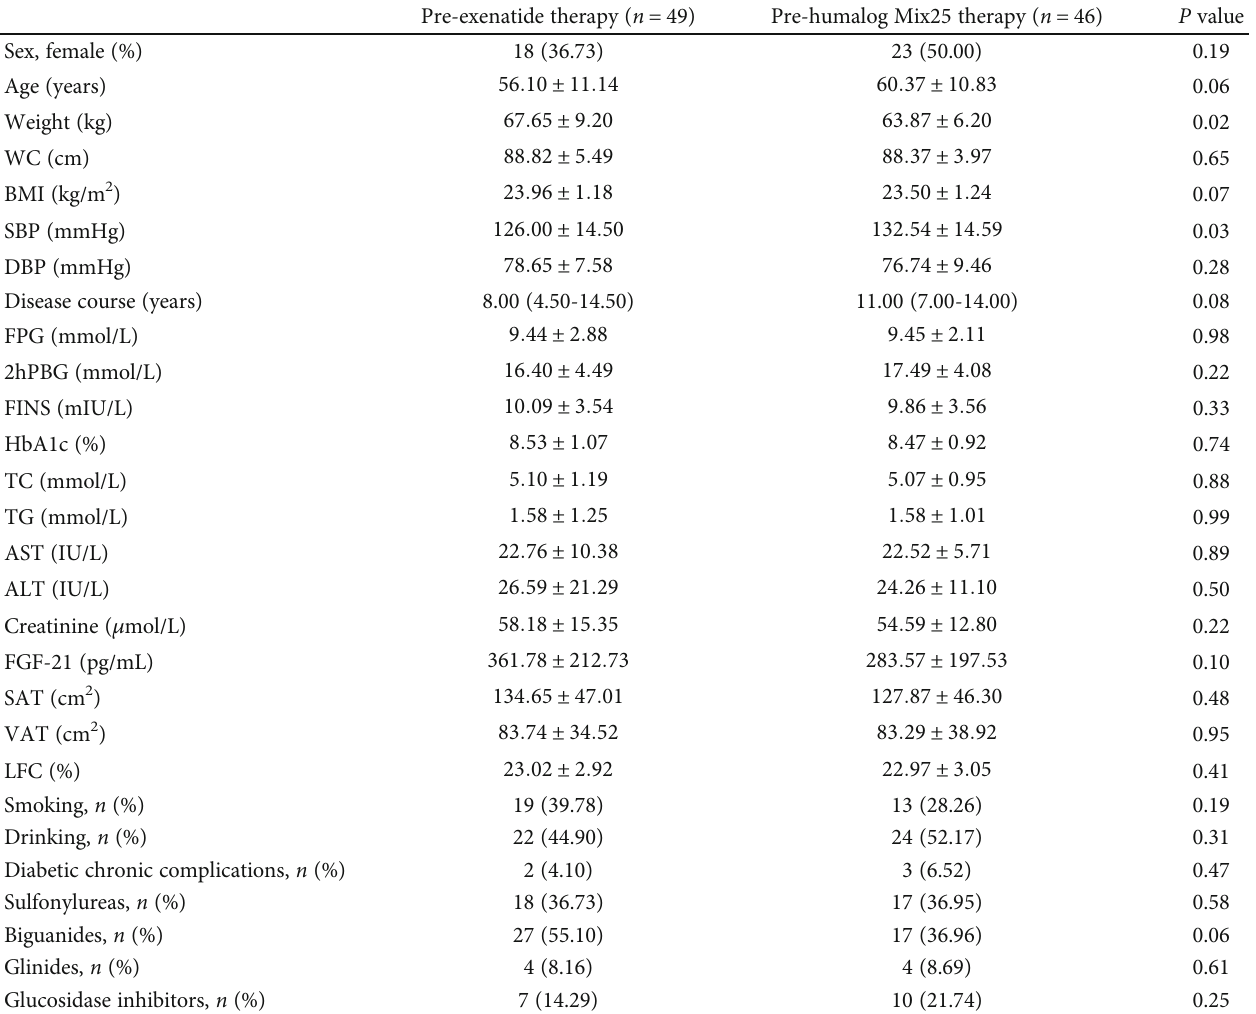
Table 1: Baseline characteristics of normal BMI patients with T2DM and visceral